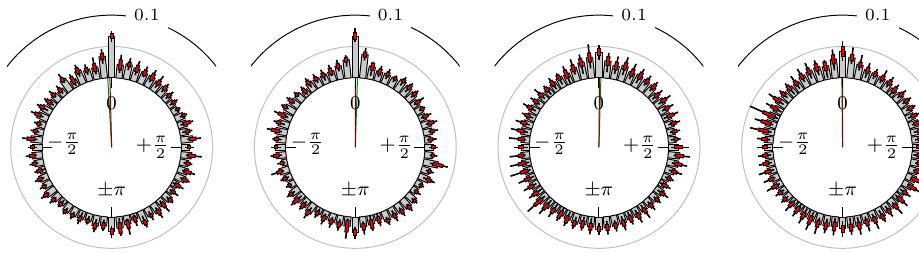
Figure 13. Gold versus Oil (WTI).